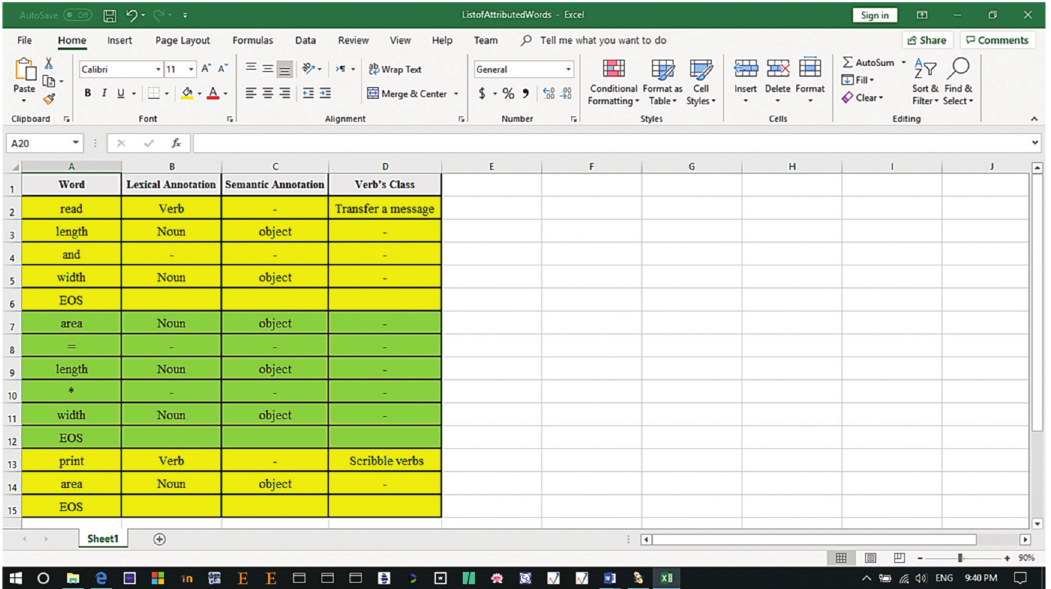
Figure 10: Excel File Showing the Structure of Finding Verb’s